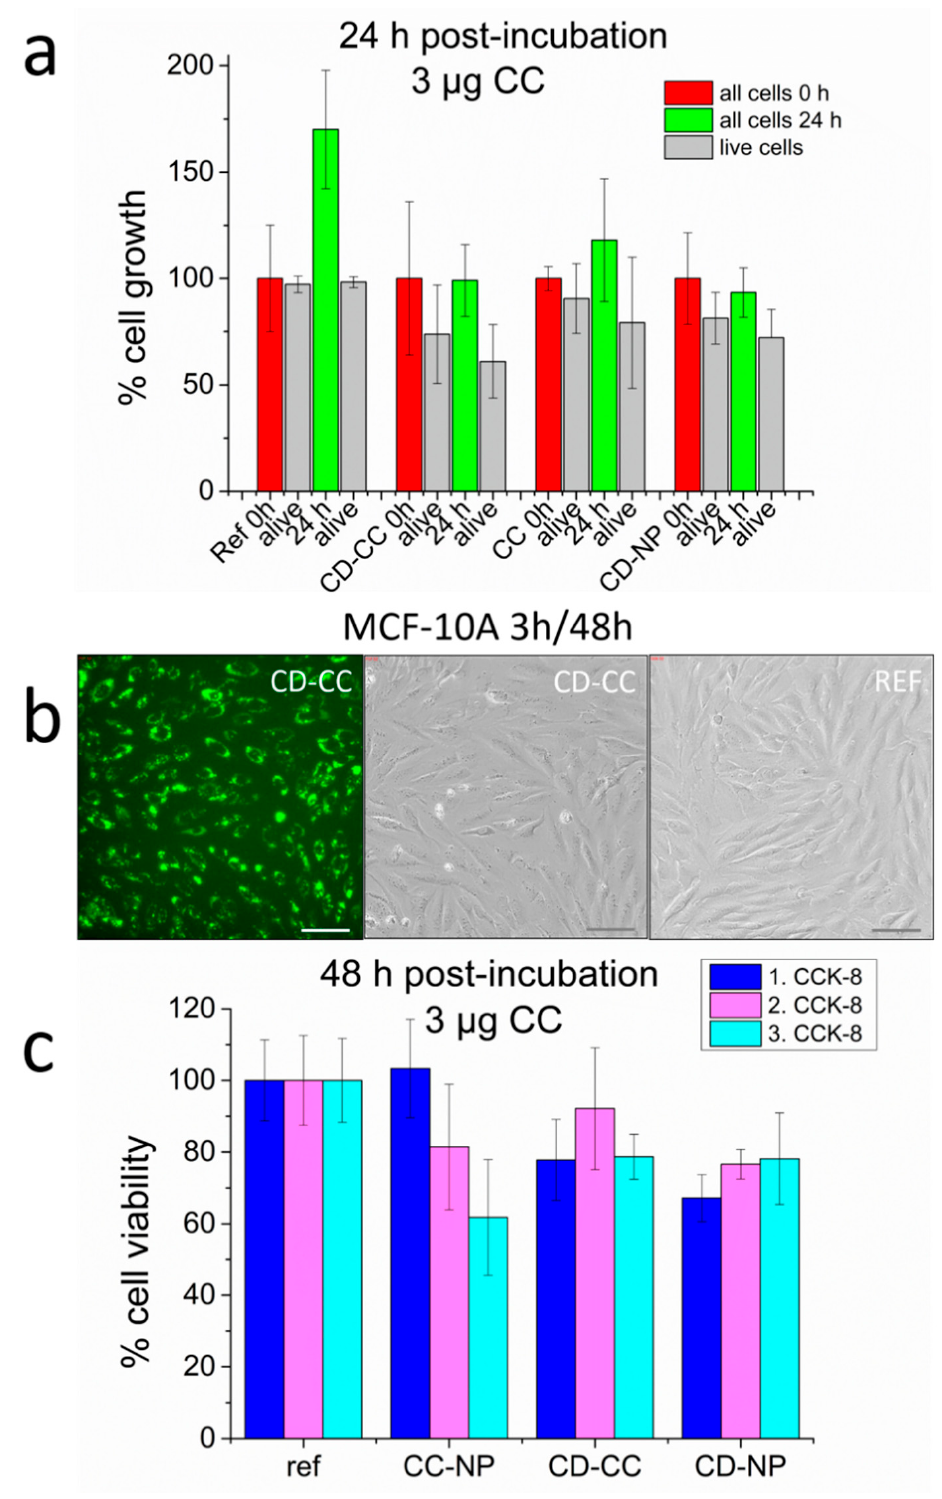
Figure 11. MCF-10A cell response to 3 µ g/well curcumin delivery, 3 h incubation: ( a ) CC delivered as CD-CC-NP and CC-NP in comparison to pure CD-NP, cell count after 24 h post-incubation (green), including the survival rate (grey), ( b ) images after 48 h post-incubation with CD-CC-NP in comparison to untreated cells, scale bar 100 µ m, ( c ) comparison of three CCK-8 assays performed after 48 h, here results for 3 µ g